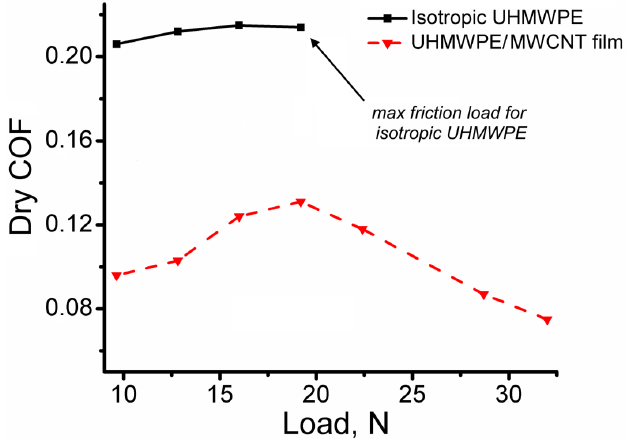
Figure 5. Dependence of the coefficient of dry friction on the load for traditional (conventional) UHMWPE with isotropic structure and bulk oriented UHMWPE/1% FMWCNT film. The traditional UHMWPE was prepared by the hot pressing method.